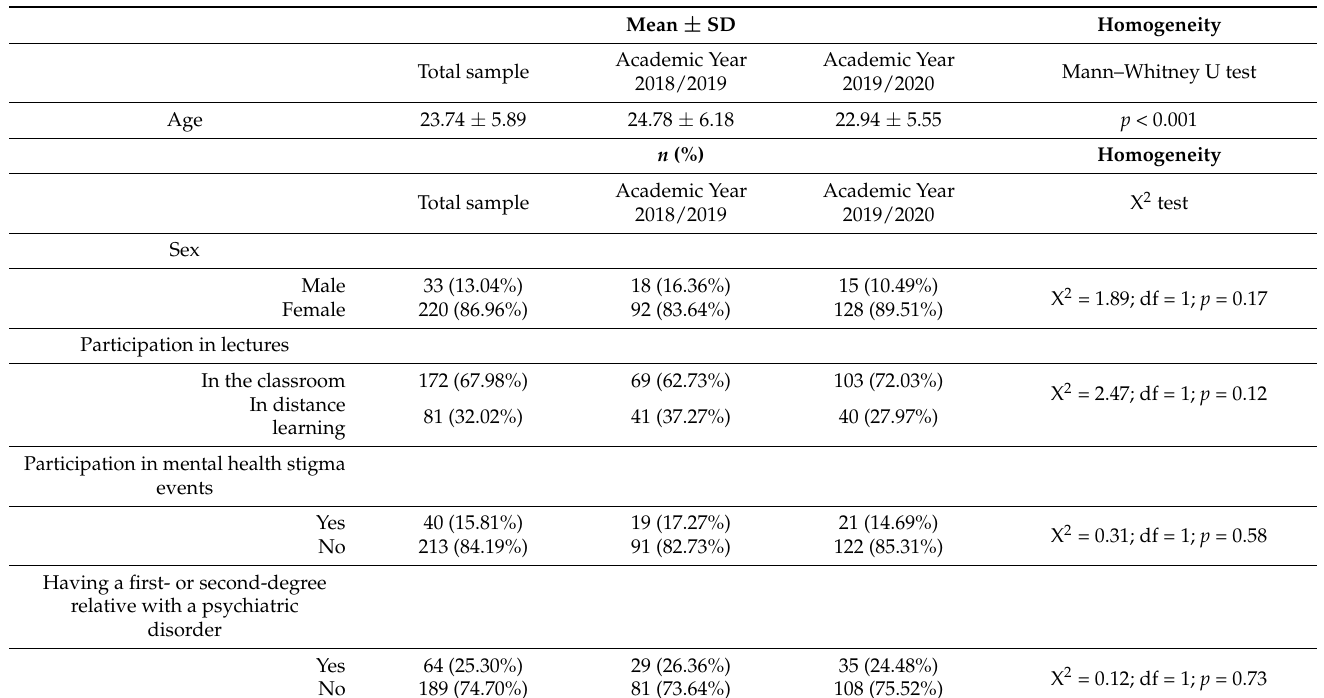
Table 1. Sociodemographic characteristics of the sample and verification of the